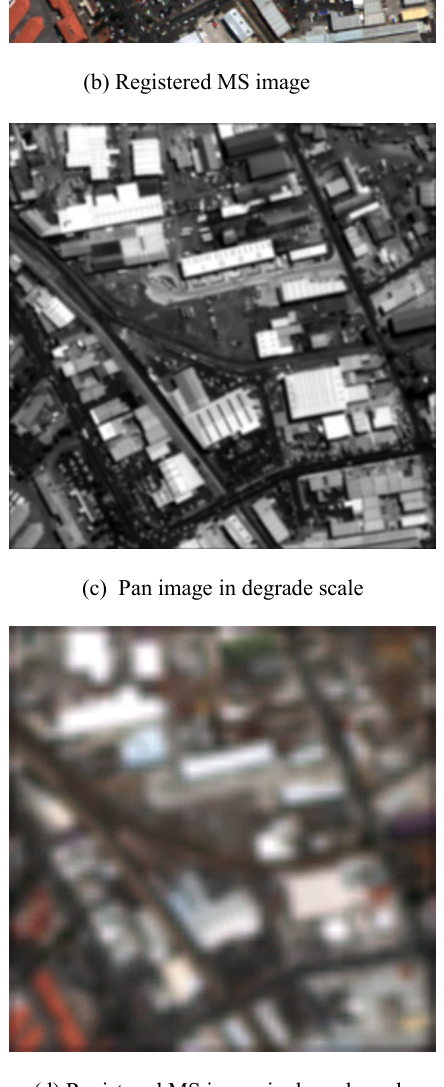
Figure 4. GeoEye-1 images and their degraded